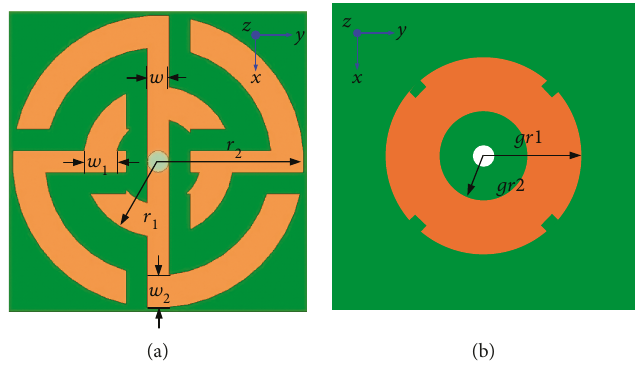
Figure 1: Top (a) and bottom (b) of the proposed antenna. Table 1: Dimensions (mm) of the proposed